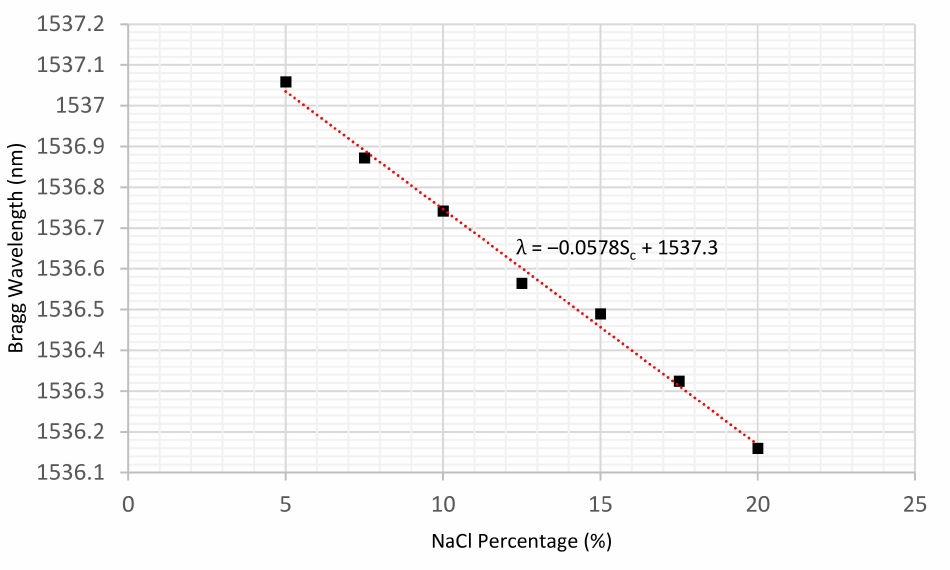
Figure 14. Linear relationship between salinity contamination and the sensor’s wavelength at a constant SWC of